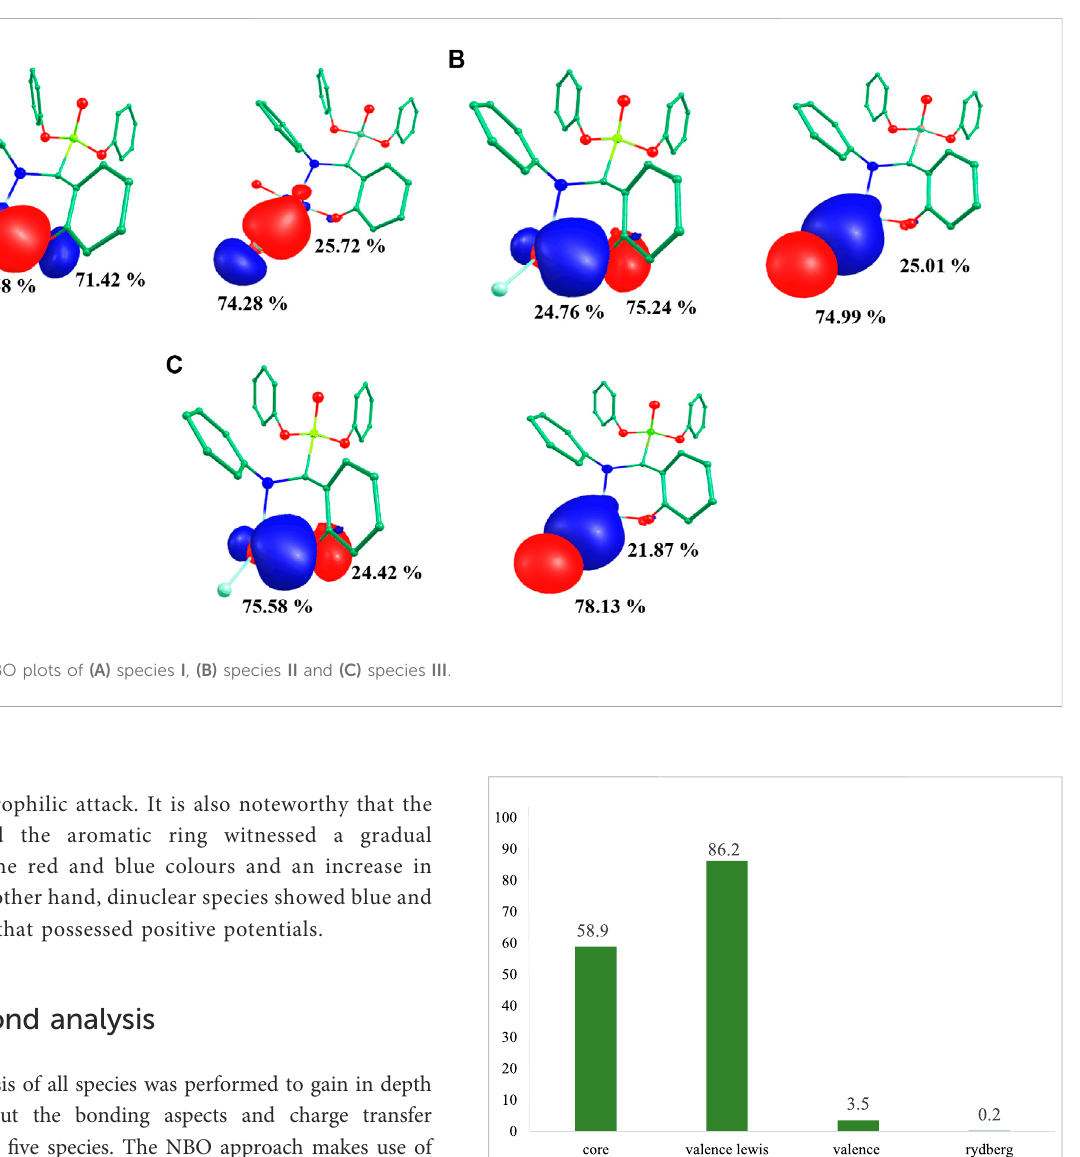
FIGURE 6 Bar diagram representing the natural population analysis of species I